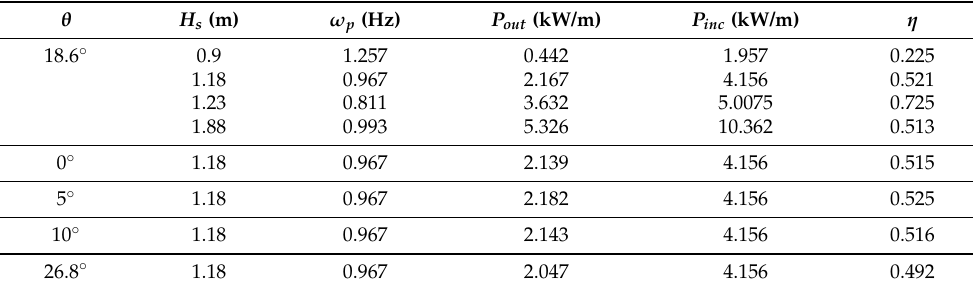
Table 2. Average power output and efficiency for the most common sea states represent the local wave climate at the western coast of